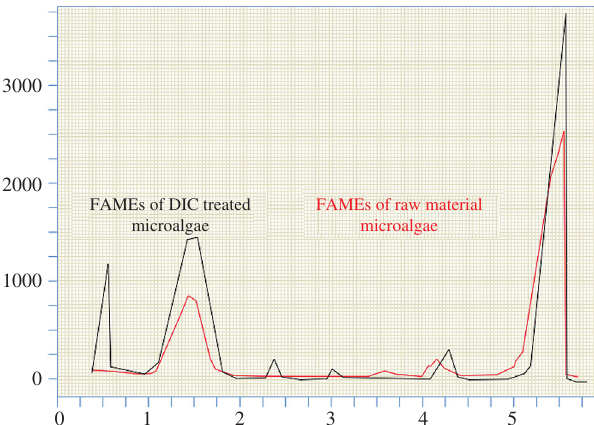
Figure 6 Liquid chromatography (LC)-flame ionization detection (FID) of fatty acid methyl esters (FAMEs) extracts of raw (red) and instant controlled pressure drop (DIC)-treated samples (black).